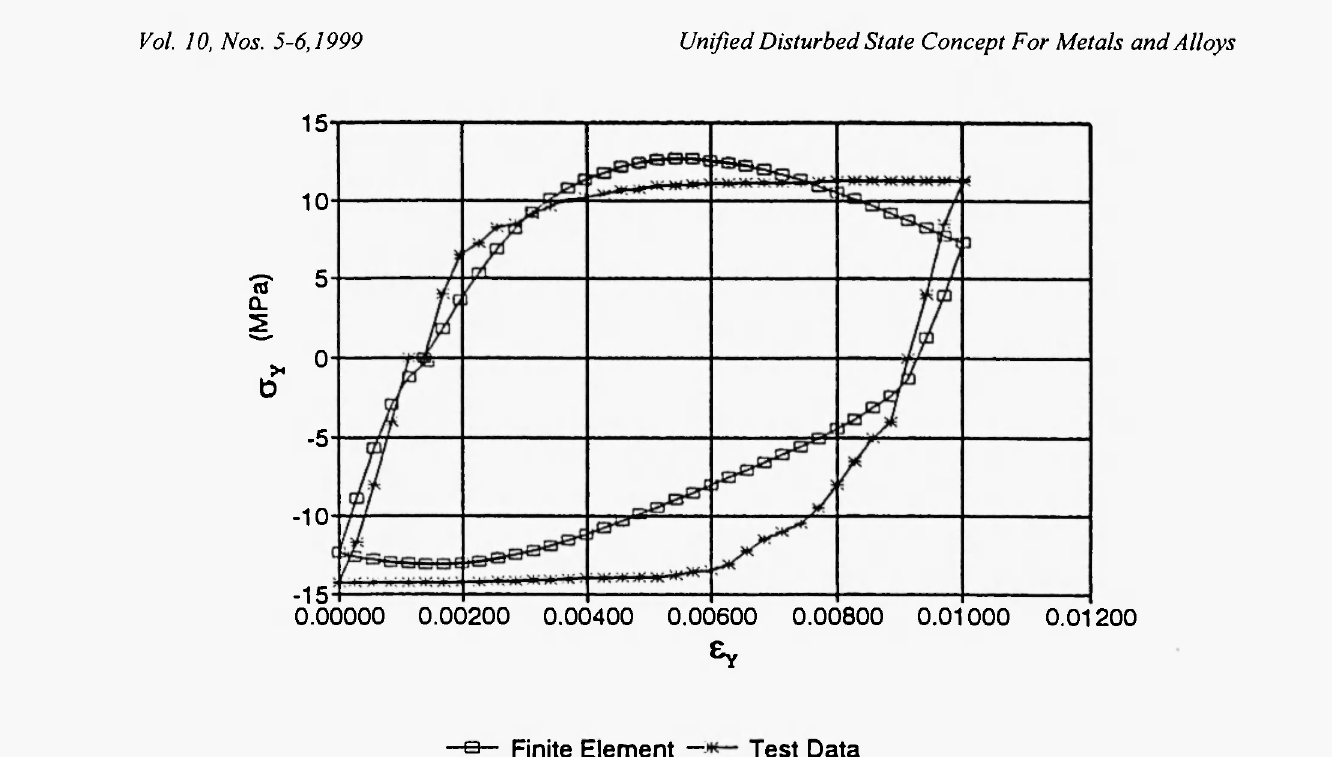
Fig. 1.12: Elasto-viscoplastic with disturbance finite element analysis results vs. isothermal (25°C) uniaxial tension test data of Pb36.37/Sn63.2/Sb0.31 solder alloy block results.